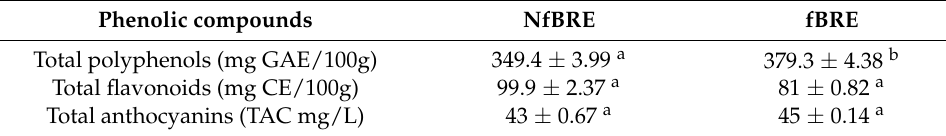
Table 3. Phenolic compounds of fermented black raspberry extract